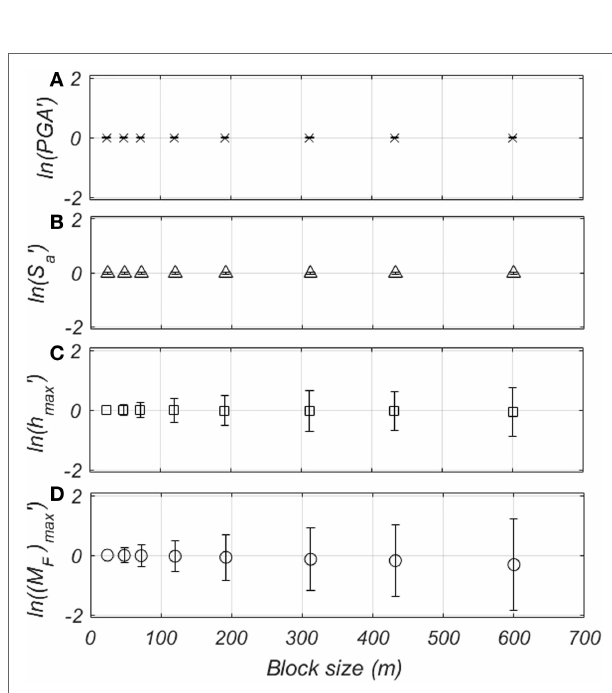
FIGURE 14 | Granularity of (A) peak ground acceleration (PGA), (B) S a ( T 1 = 0.3s), (C) h max , and (D) ( M F ) max for 1,000-year event.